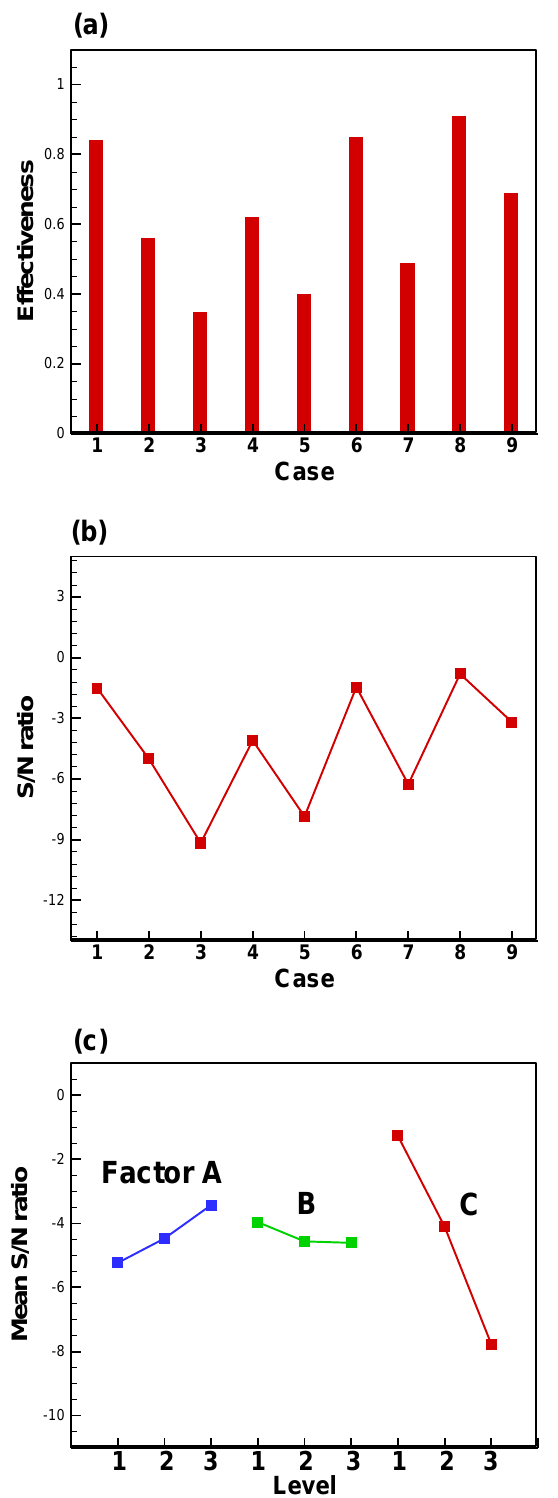
Figure 9. ( a ) Effectiveness and ( b ) S/N ratio for the nine cases in the orthogonal array, and ( c ) mean S/N ratio variations for factors A, B, and C with three levels.